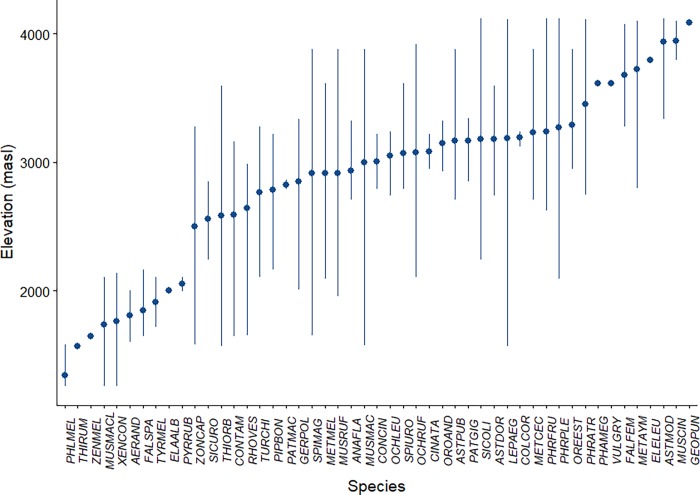
Elevational range sizes for 49 species occurring along an altitudinal gradient in the Dry Tropical Andes of northern Chile, between November 2016 and August 2017.Lines indicate the maximum and minimum elevational limits of each species range, and species are ordered along the abscissa by ranked elevational midpoints (range average). See “S1 Appendix” for codes of bird species.